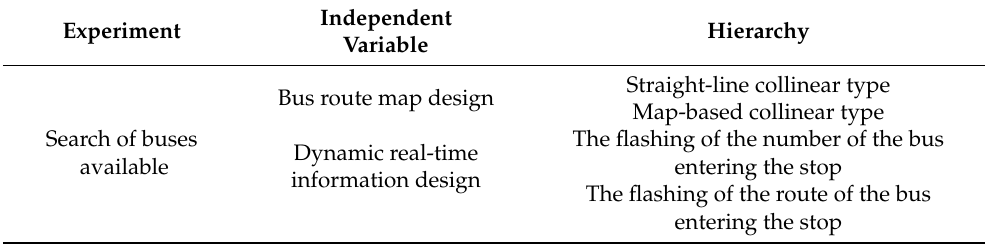
Table 1. Experimental Sample Variables.